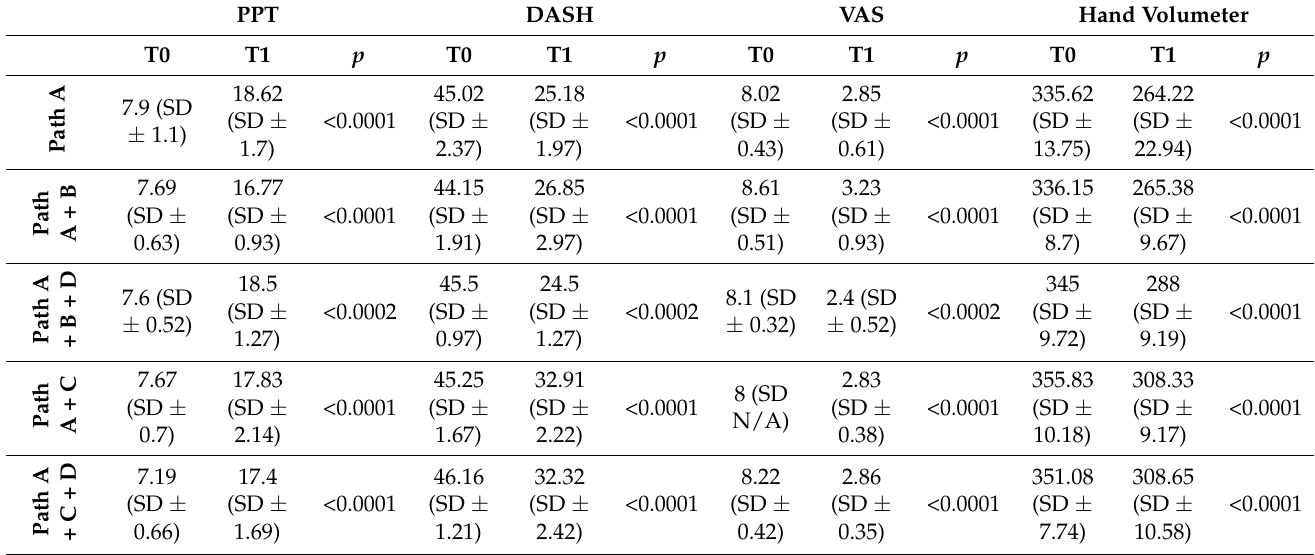
Table 2. Pre (T0) and post-treatment (T1) scores for PPT, DASH, VAS, and hand